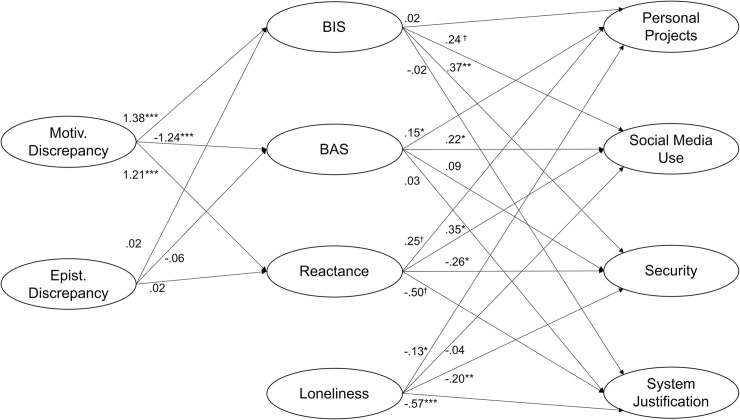
Structural equation model.χ2/df = 1.67, CFI = .869; RMSEA = .041; SRMR = .067. Note: The model shows the unstandardized regression coefficients. For regression and mediation paths, see Tables 2 and 3. BIS: behavioral inhibition system-related anxiety; BAS: behavioral activation system-related approach-affect. * p <. 05; ** p < .01; * p < .001.